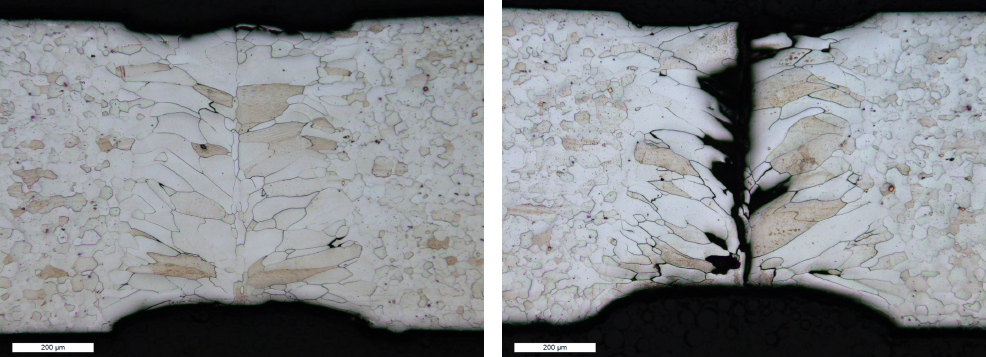
Figure 15. Etched cross-sections of AISI430Ti after exposure to the corrosive environment for 20h, both welded at an energy input of 20 J · mm − 1 and extracted from a single weld